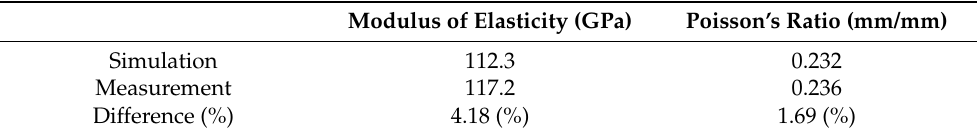
Table 8. Difference between simulation and measurement for Type I.